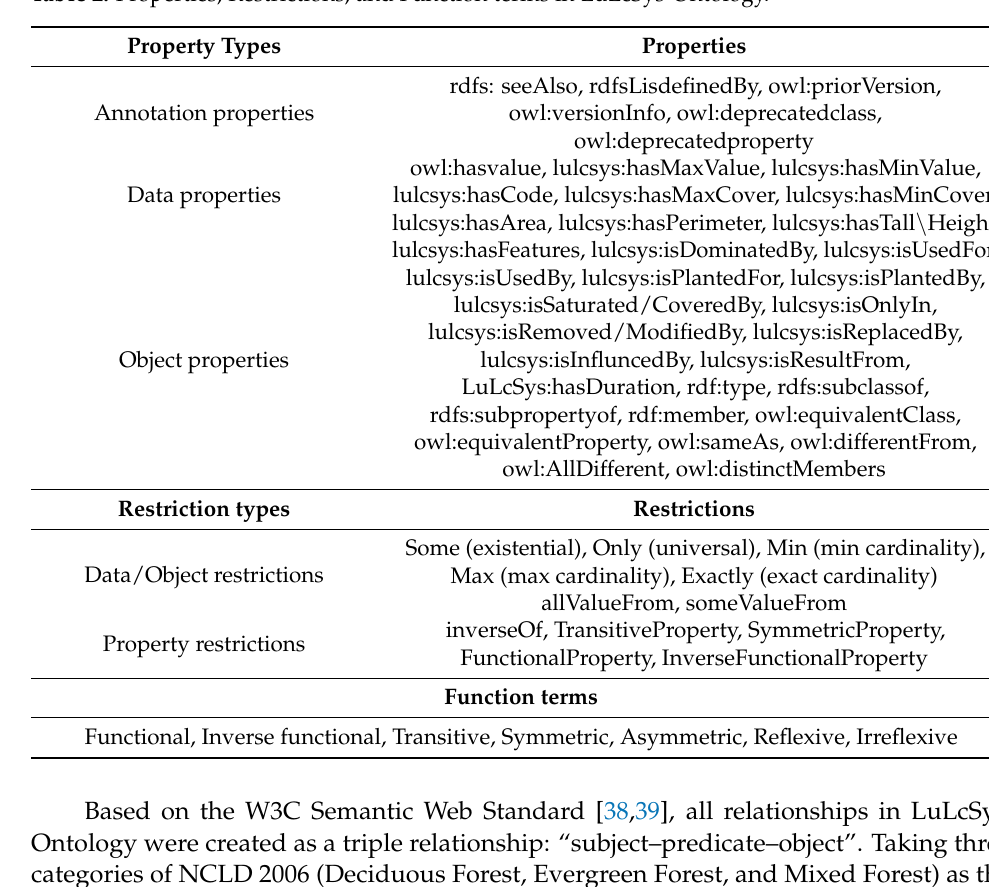
Table 2. Properties, Restrictions, and Function terms in LuLcSys-Ontology.